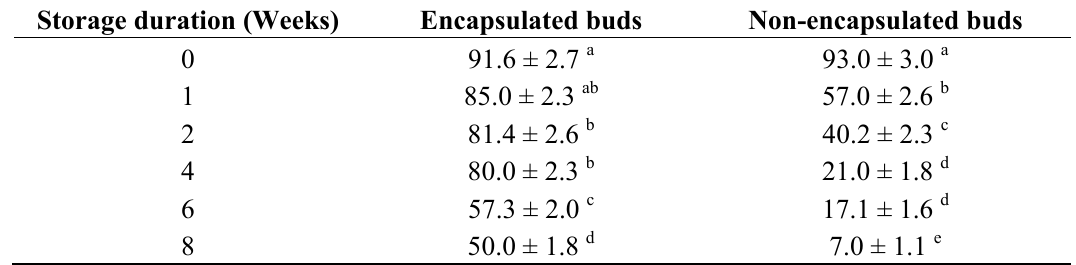
Table 1. Effect of different duration of storage at 4 °C on the conversion of encapsulated and non-encapsulated nodal segments R. serpentina after 8 weeks of culture on woody plant medium supplemented with 5.0 µM BA and 1.0 µM NAA a .